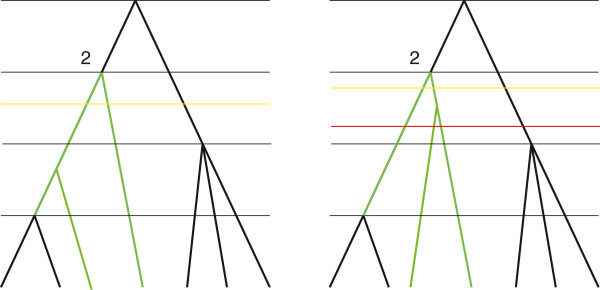
Defining matrices m andM. Two trees that resolve a constraint tree from Figure 4 (only resolutions of subtree 2 are shown) and three ways to draw a horizontal line. The yellow lines correspond to the minimal number of intersections and the red line, to maximal. Thus, m2,2=2 and M2,2=3. We can also note that m1,2=M1,2=1.